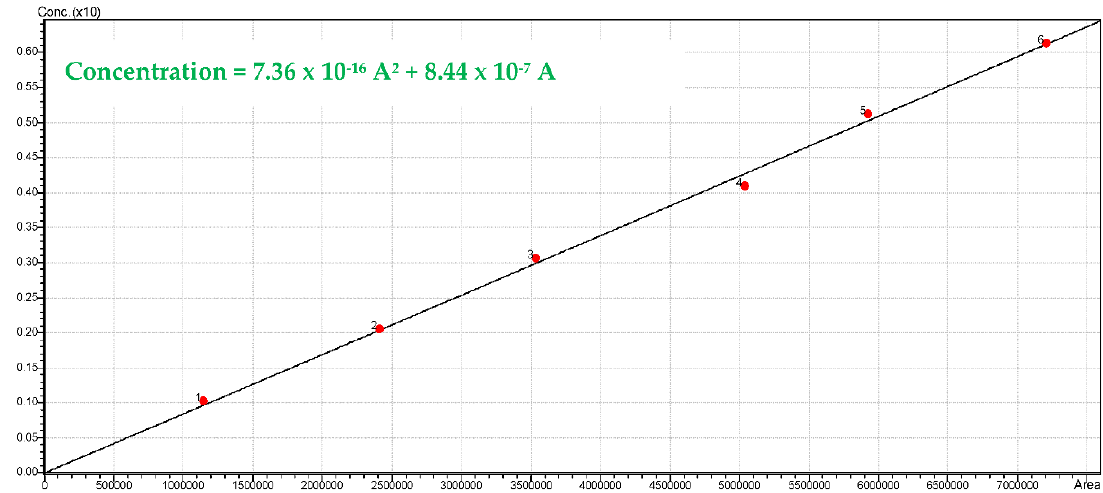
Figure A4. Calibration curve using the Shimadzu GC 2010 for hydrogen.